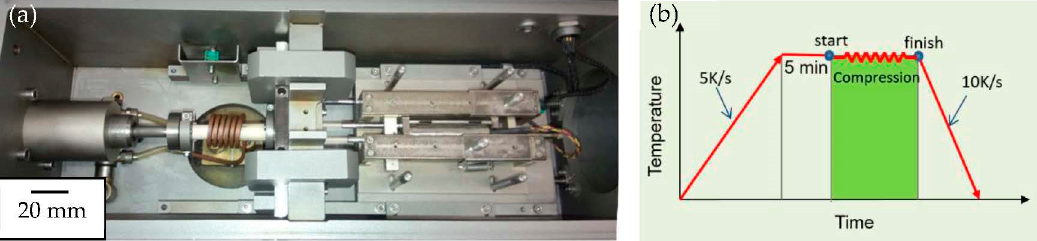
Figure 2. ( a ) Dilatometer used for hot compression tests and ( b ) the thermomechanical cycle ap-